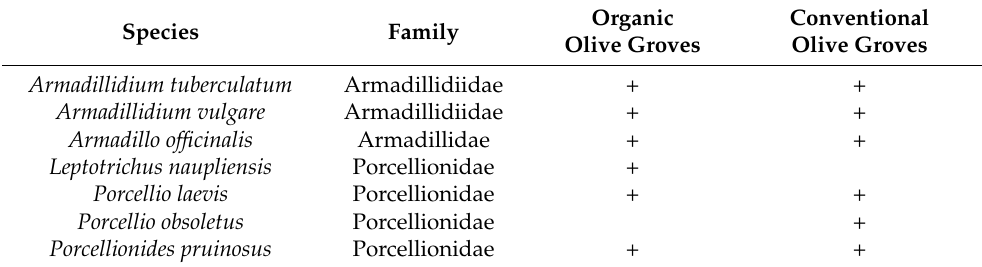
Table A4. Isopod species recorded in organic and conventional olive groves. Species nomenclature based on Schmalfuss (2003; 2008) [90,91].